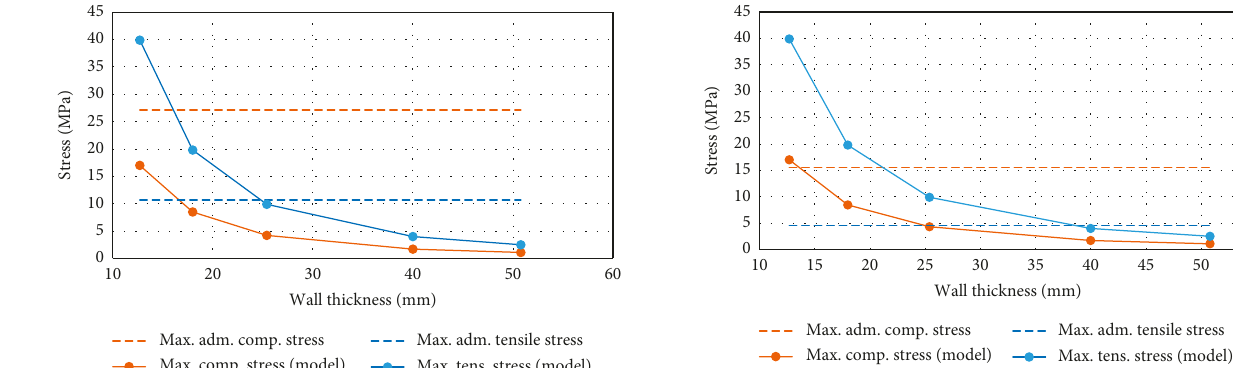
Figure 10: Comparison between maximum tensile and com- pressive stresses and maximum admissible tensile and compressive stresses for Utility Structure 1 as a function of the wall thickness (shell model).